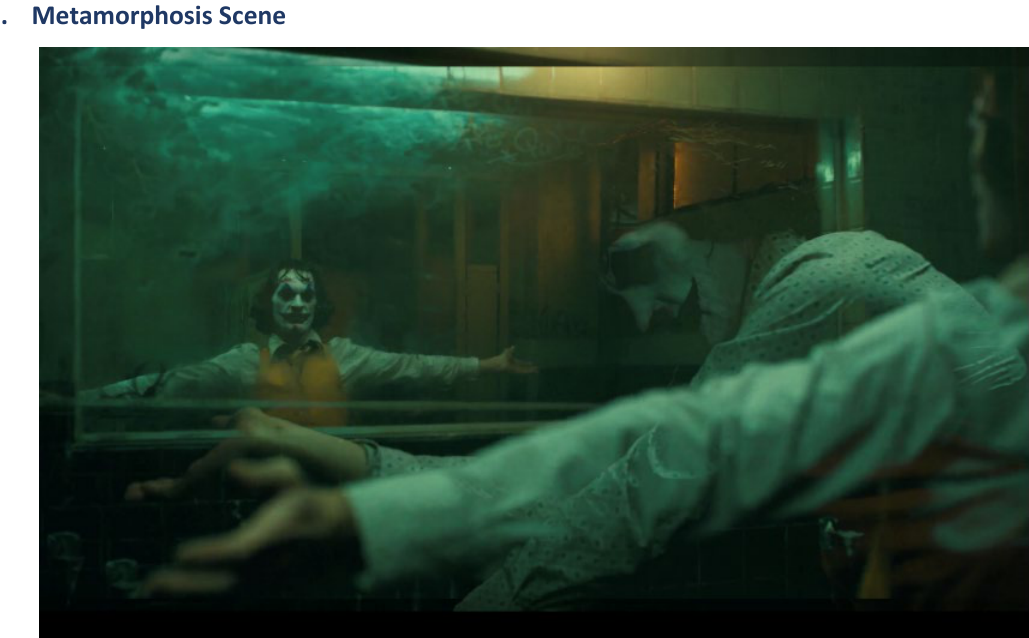
Figure 56 Digital collage of the Metamorphosis